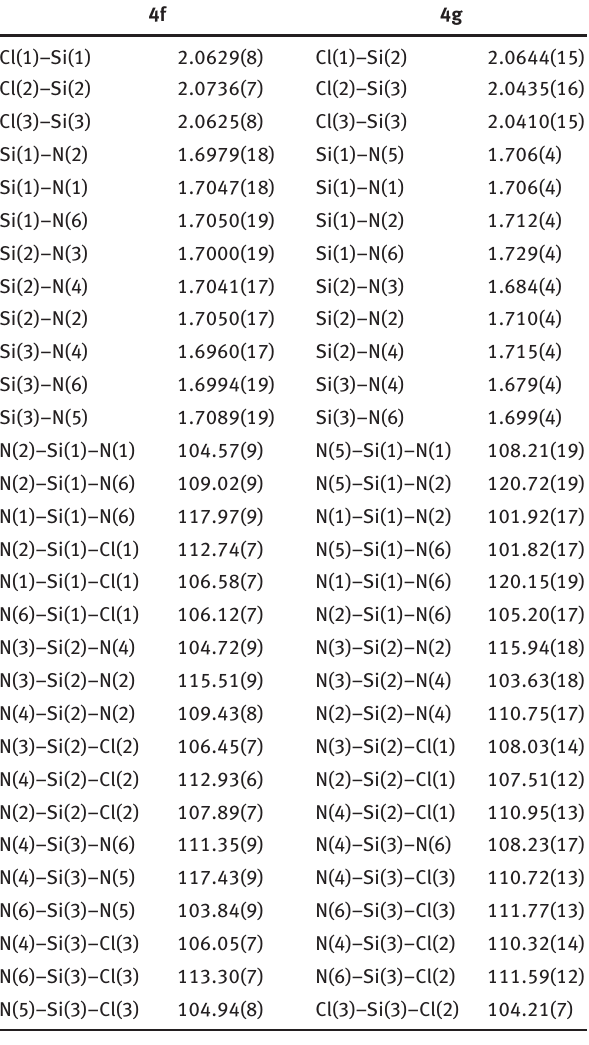
Table 8: Selected geometric parameters (Å, °) of 4f and 4g 4f